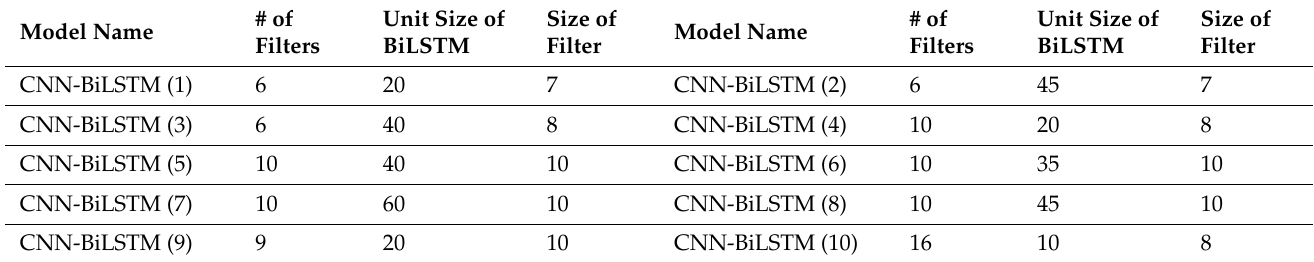
Table 4. Parameterization for 10 different CNN + BiLSTM models.